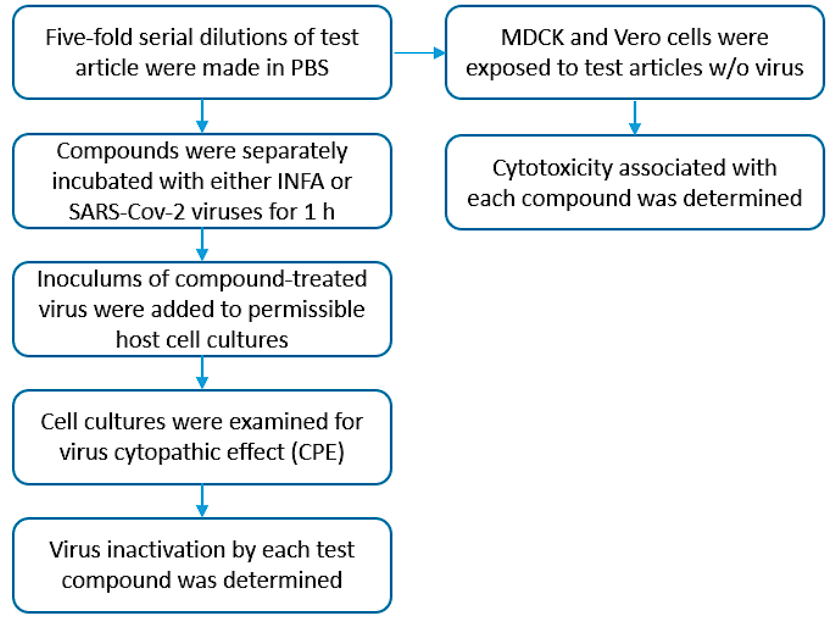
Figure 3. Testing schematic. Simplified diagram outlining general steps accomplished during the testing process. testing